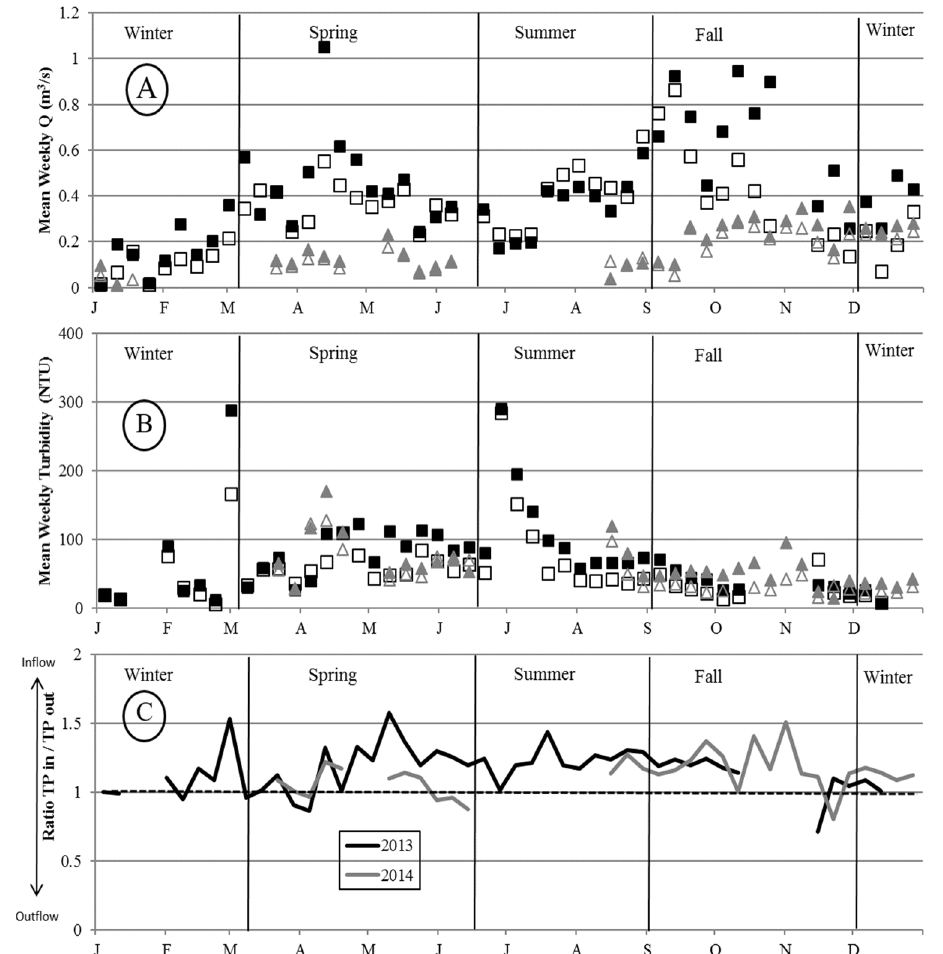
Figure 2. ( A ) Mean weekly discharge (Q, m 3 /s), ( B ) mean weekly turbidity (NTU), and ( C ) ratio (in/out) of mean weekly estimated total phosphorus (TP) concentration (mg/L), in (cid:3) 2013 and (cid:52) 2014 for outflow from the wetland to the creek; and (cid:4) 2013 and (cid:78) 2014 inflow from the creek; at the water-control structure between Crane Creek and Pool 2B, on the Ottawa National Wildlife Refuge, Oak Harbor, OH. See text for date ranges of seasons. Ratios greater than one indicate rates were higher during flow into the pool. Ratios less than one indicate rates were higher during out flow.